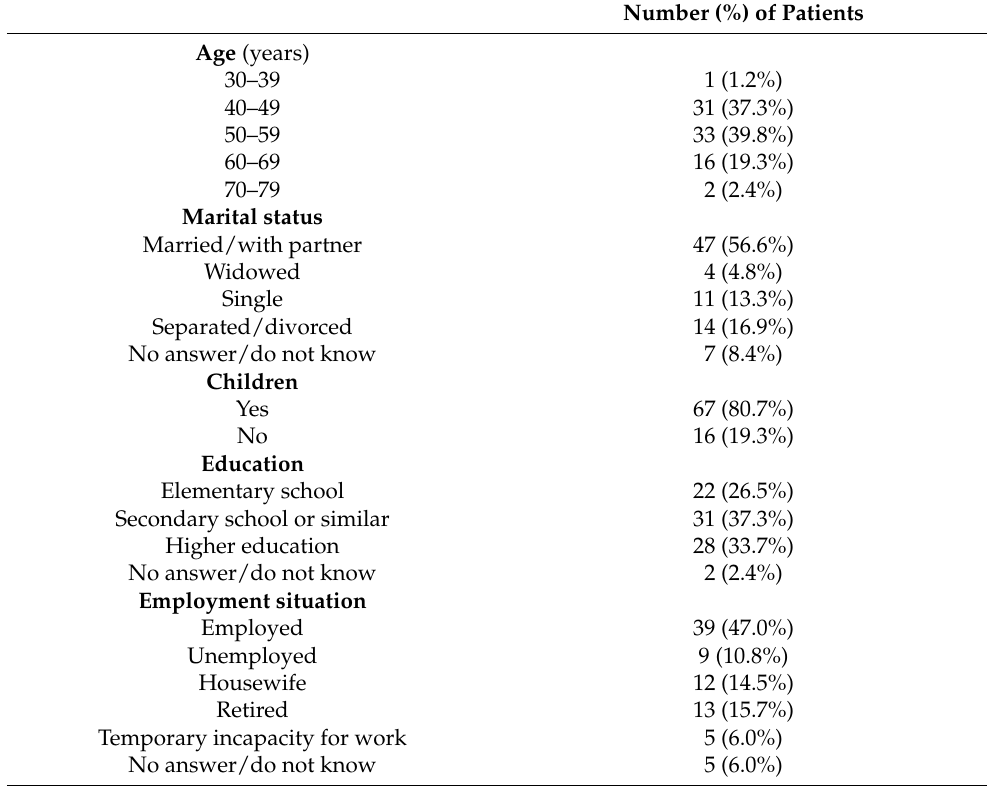
Table 1. Sociodemographic characteristics of the sample ( n = 83).